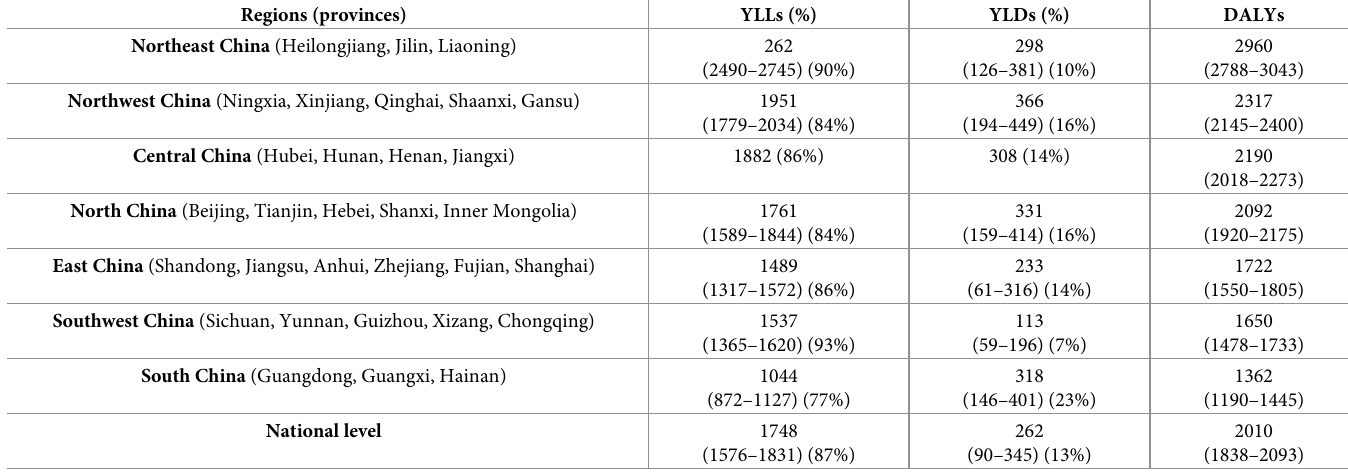
Table 2. YLLs, YLDs and DALYs per 100,000 people (95%UI) in seven regions nationwide, and the respective percentage � . Regions